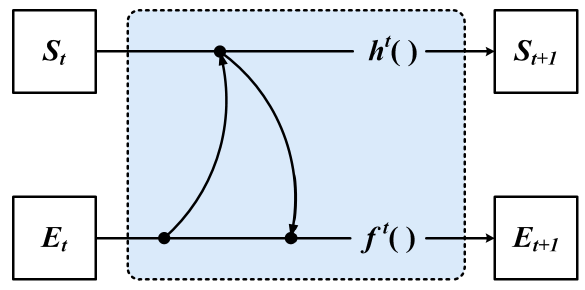
Figure 6. The encoding neighbor method.